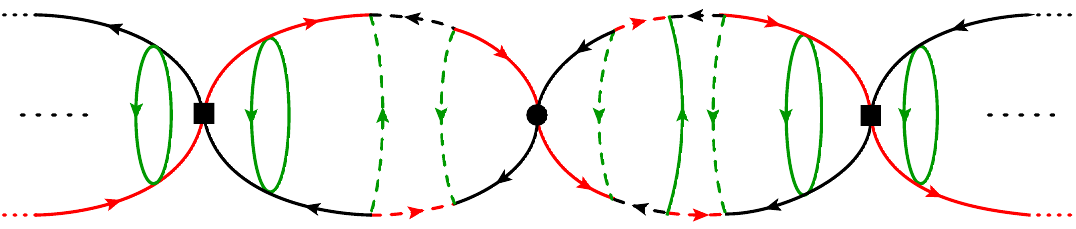
. The black (cid:30) 1 (cid:30) y 2